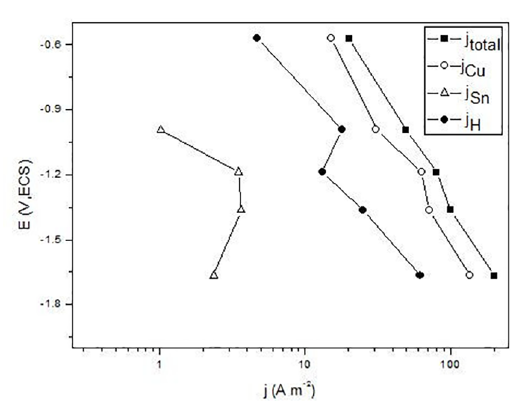
Figure 3. Partial current densities obtained in the deposition process for the metals Cu and Sn and also for the hydrogen reduction